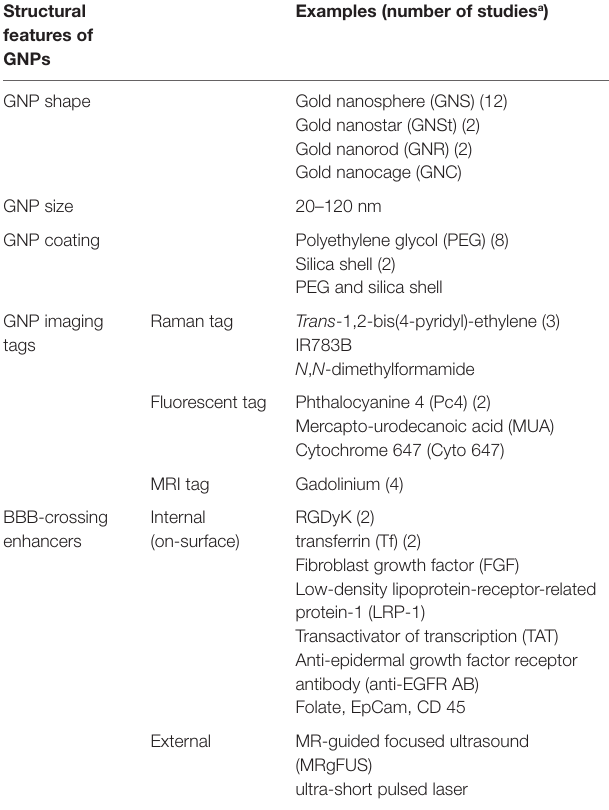
taBLe 3 | Structural components of the GNPs for brain tumor diagnosis. Structural features